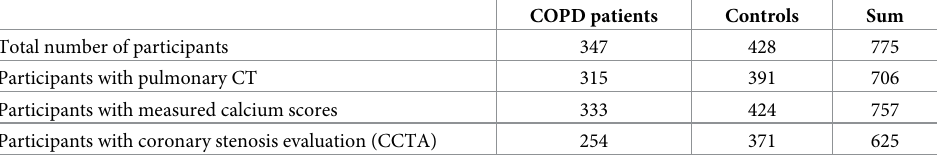
Table 1. Overview of the study population who underwent pulmonary CT, CCTA, and measured